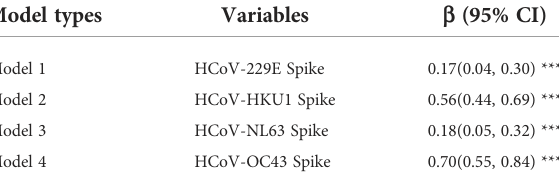
TABLE 2 Multivariate analysis of cross-reactivity between exposure to endemic coronaviruses and SARS-CoV-2 antibody concentration among vaccinated